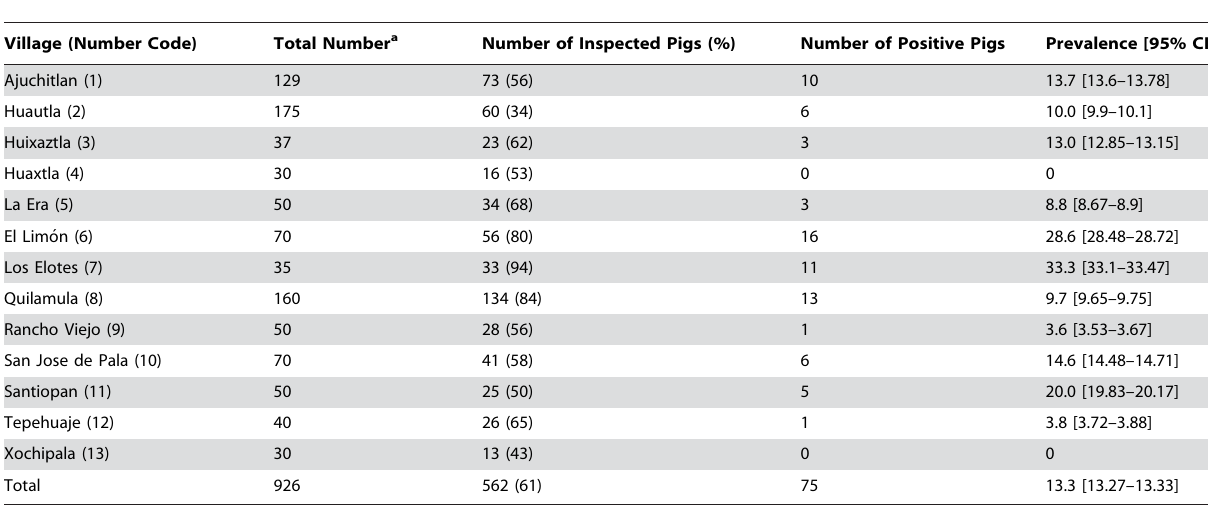
Table 2. Prevalence of pig cysticercosis in 13 rural villages of the Sierra de Huautla, Morelos.